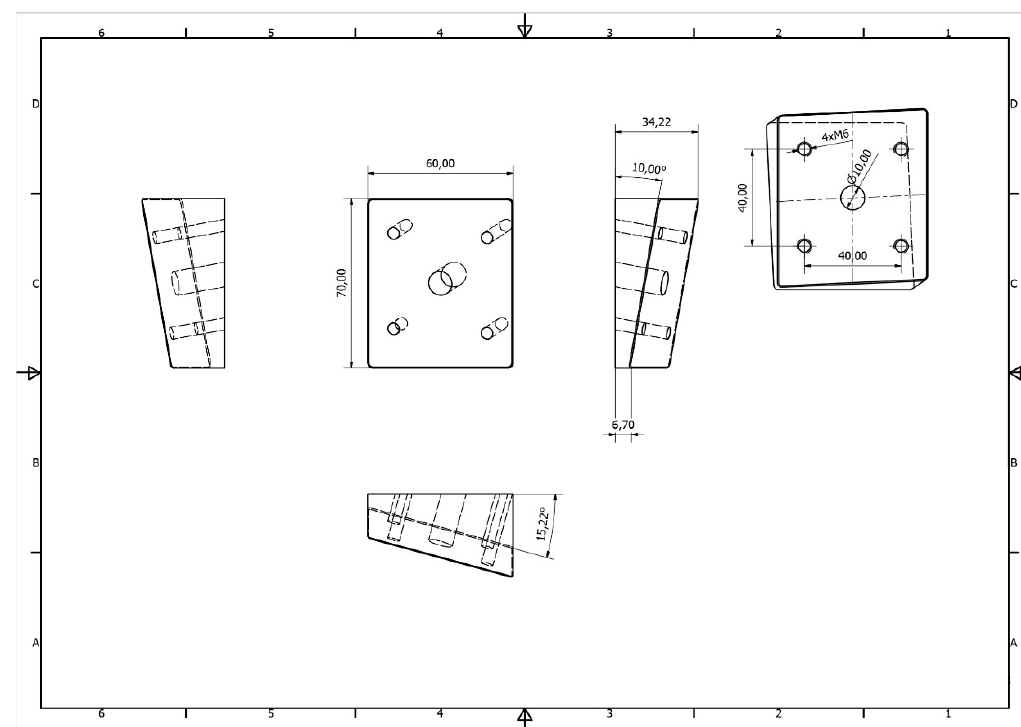
Figure 2. Technical drawing of individually designed stainless steel base plate for mechanical tests of mandibles.